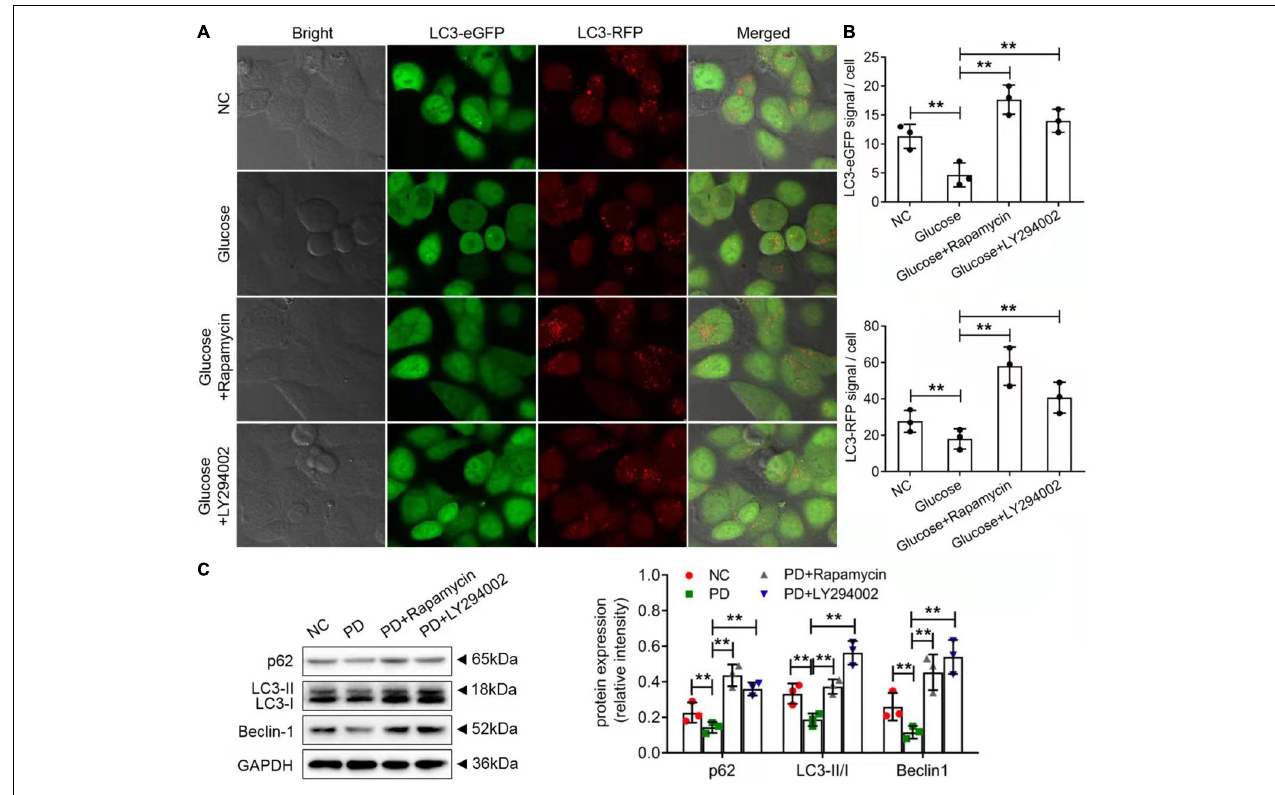
FIGURE 6 | Rapamycin and LY294002 affected autophagy-related degradation processes on HG-induced peritoneal fibrosis in vitro and in vivo . (A) The autophagic cell-death model was replicated in vitro using rat PMCs and the autophagy inducer, rapamycin and LY294002. Immunofluorescence staining was performed on the autophagy marker, LC3 protein. (B) The quantitative analysis of the result in (A) . (C) Western blot and quantitative analysis detected autophagy-related protein expression in the peritoneum of control rats, PD rats and PD rats treated with LY294002 or rapamycin. Three rats in each group were prepared. Columns represent the means ( n ≥ 3); bars represent the SD; ** P <